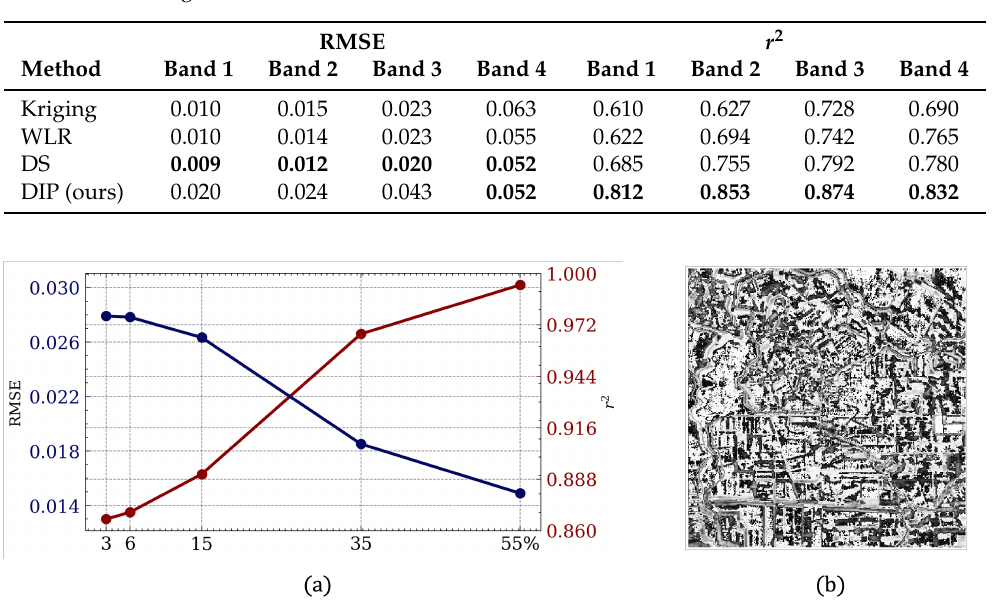
Figure 2. Simulation results. ( a ) Comparative statistics. X-axis: percentage of corrupt pixels. Y-axis (left): root mean squared error (RMSE) between simulated and real pixel values. Y-axis (right): corresponding coefficient of determination ( r 2 ). ( b ) Pixel-wise similarity visualization for case with 55% hidden pixels (worst case scenario). White shows higher level of similarity, while dark gray represents